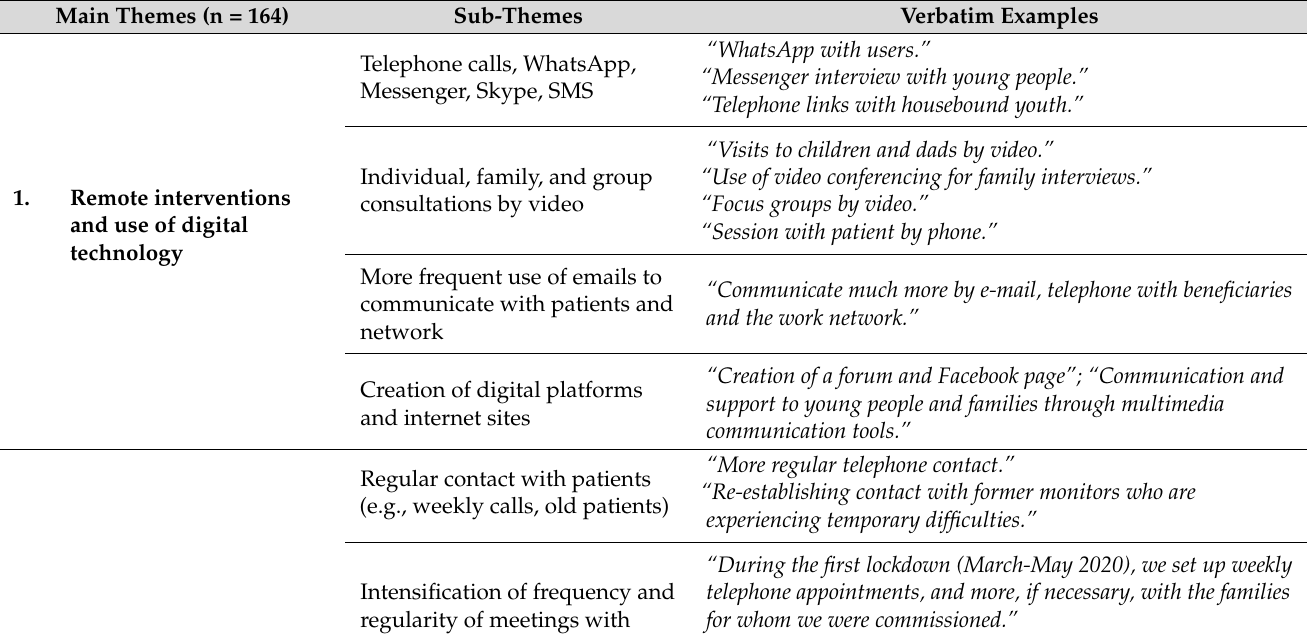
Table 7. Thematic analysis of the practices developed by psychologists during the COVID-19